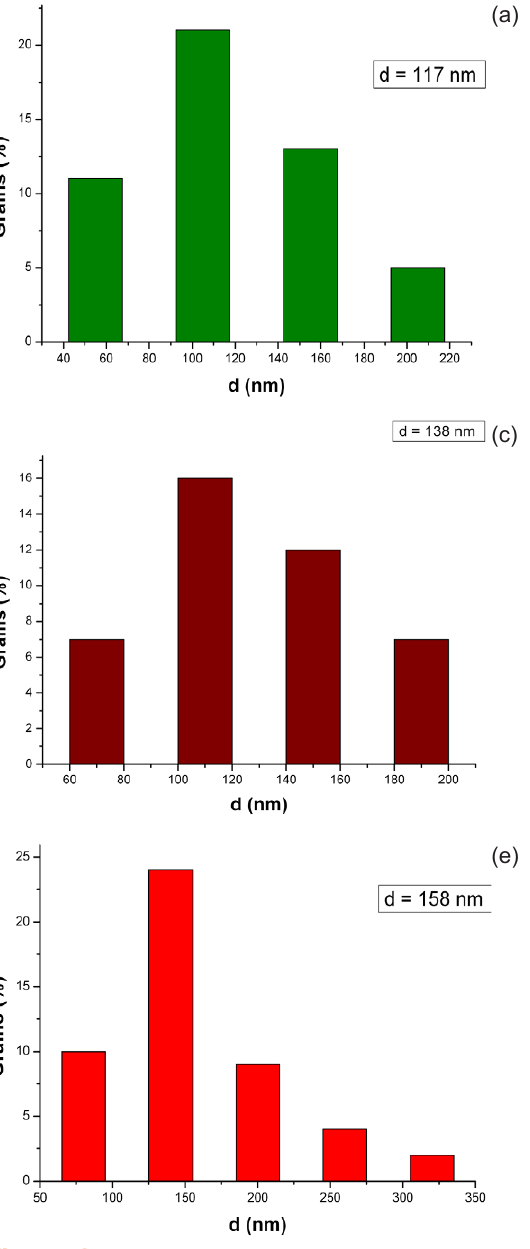
Figure 9. (a) Particle distribution for MFO-CA at 1173 K; (b) Particle distribution for MFO-CA-C at 1173 K; (c) Particle distribution for MFO-TA at 1173 K; (d) Particle distribution for MFO-Gly at 1173 K; (e) Particle distribution for MFO-HA at 1173 K; (f) Particle distribution for MFO-U at 1173 Factors that affect the width and shape of the hysteresis cycle are: synthesis technique, cation distribution,